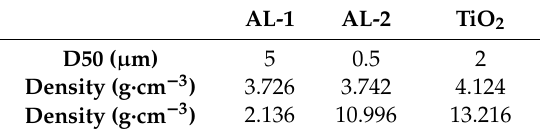
Figure 1. Preparation processes of the microwave dielectric ceramic filter. Table 1. Characteristic parameters of the raw